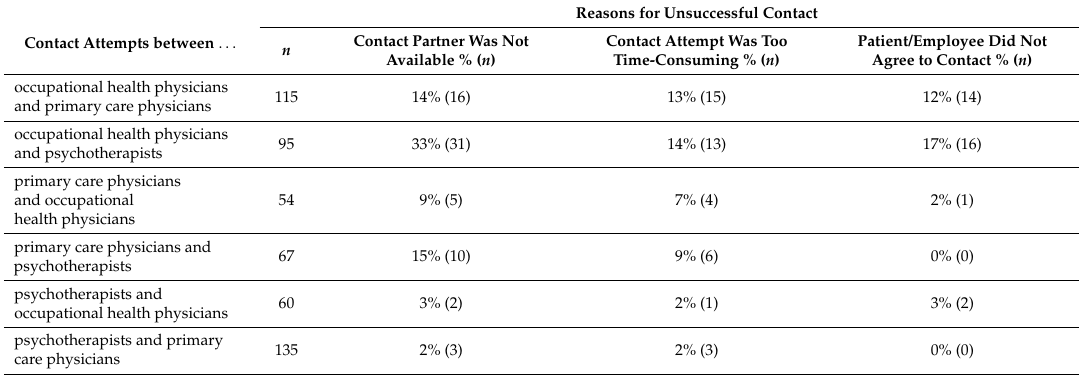
Table 3. Reasons for actively initiated but unsuccessful contact with members of the other professional groups.